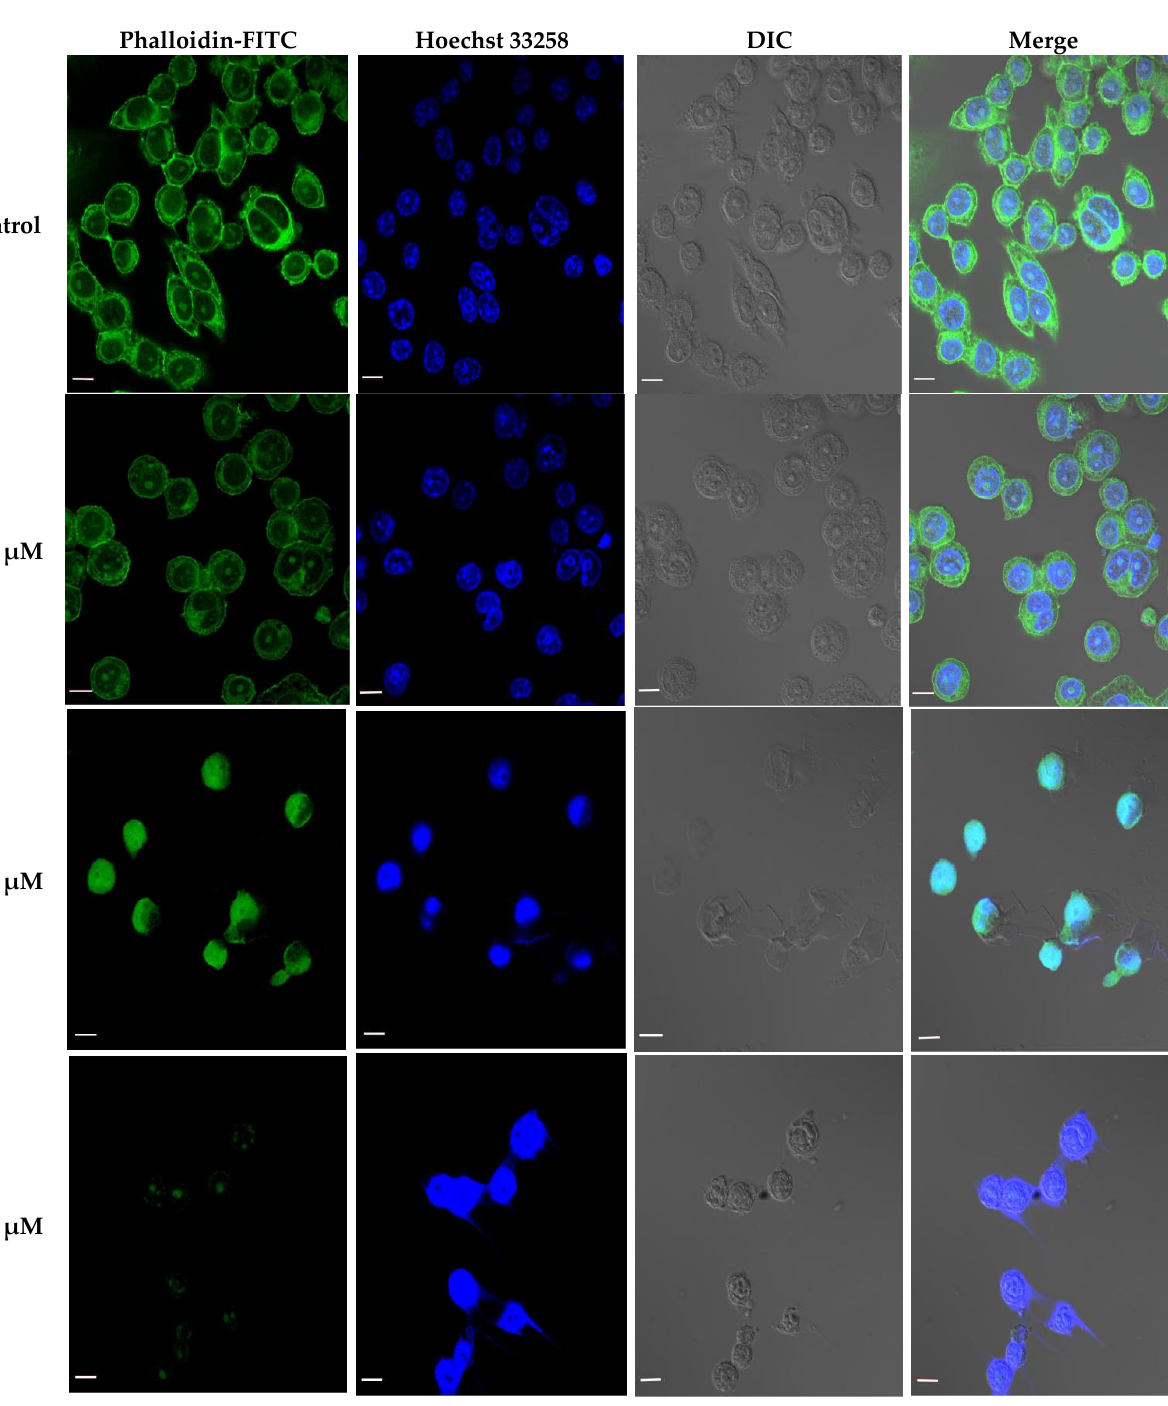
Figure 8. Effect of rAj-Tspin on the cytoskeleton and nuclei of the LLC cells. Green indicates the cytoskeleton marked by the phalloidin-FITC. Blue indicates the nuclei marked by Hoechst 33258 (Zeiss laser-scanning confocal microscopy, 630×). The bar indicates 10 μ m.